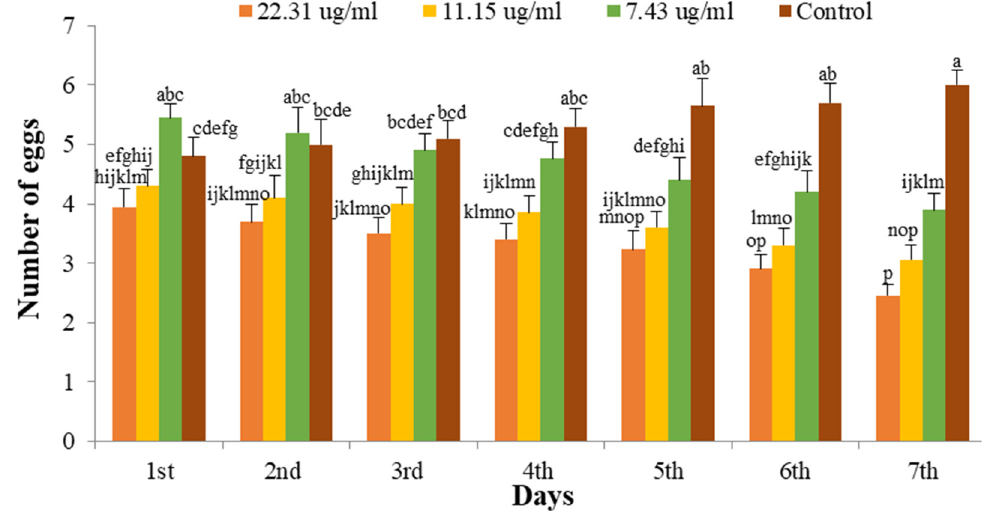
Figure 2. Mean rate of fecundity (±SE; n = 10) of Bemisia tabaci treated with different concentrations of a protein extracted and partially purified from EPF Lecanicillium lecanii . Treatment bars with dissimilar letters differ significantly from each other (one-way ANOVA; LSD post-hoc test ( p ≤ 0.05) (cf. Table 2).